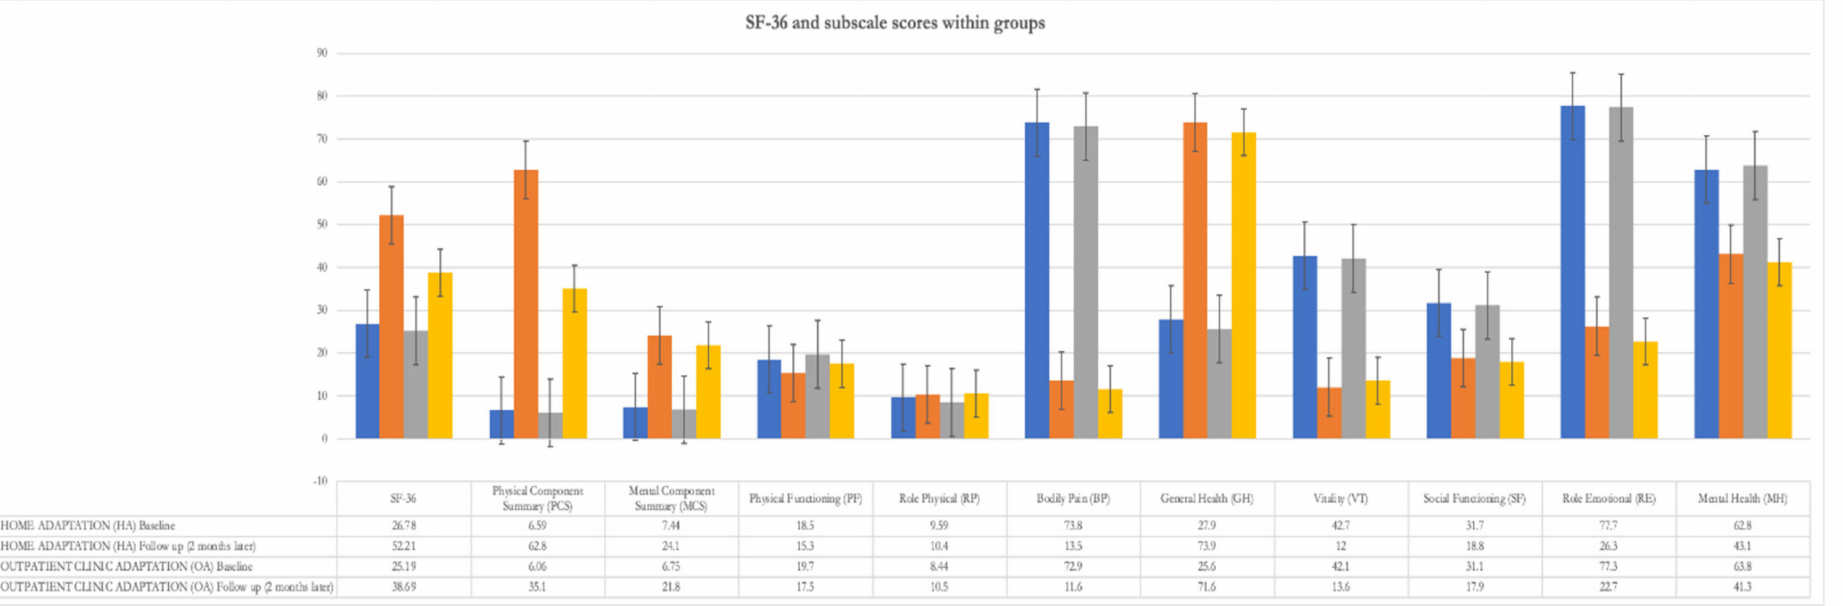
Figure 4. Development of scores from the SF-36 subscales before and after adaptation to NIV in the two